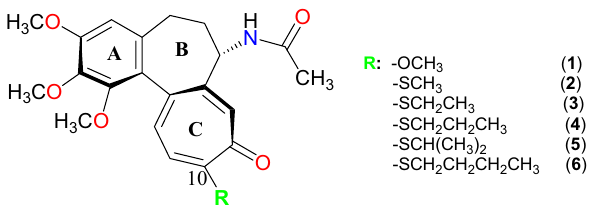
Figure 1. Colchicine 1 and its derivatives 2–6